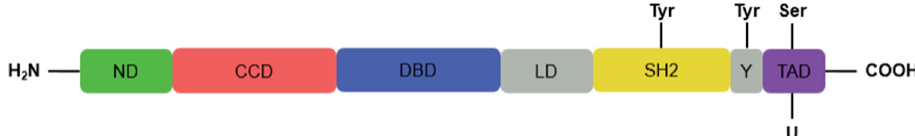
Figure 1. Schematic illustration of STAT domains. STAT proteins consist of seven domains: N- terminal domain (ND), coiled-coil domain (CCD), DNA binding domain (DBD), linker domain (LD), SRC homology 2 (SH2) domain, phosphotyrosyl-tail (Y) segment, and transactivation domain (TAD). In addition, phosphorylation sites are provided as tyrosine (Tyr) residues on the SH2 domain and Y segment and as serine (Ser) residues on the TAD domain. TAD domain is also involved in ubiquitination (U).